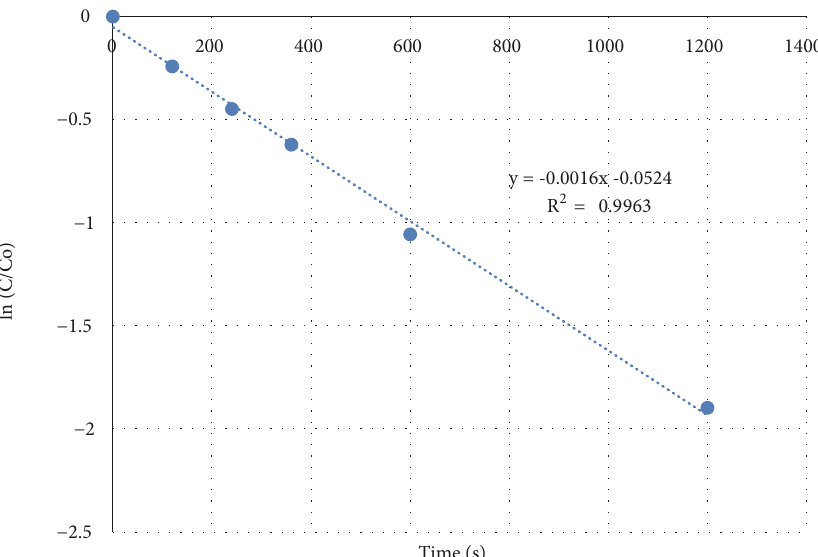
Figure 2: Example MC-LA pseudo-first-order oxidation with 2.0 ppm permanganate.